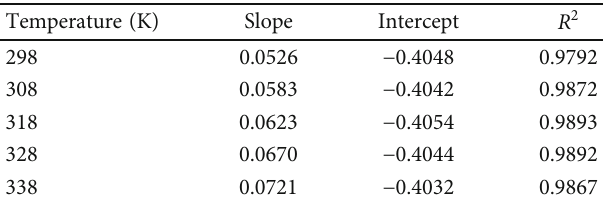
Figure 16: Plots of Boyd ’ s fi lm model for HF adsorption on 3A. Table 6: Kinetic parameters of linear fi tting of fi lm di ff usion